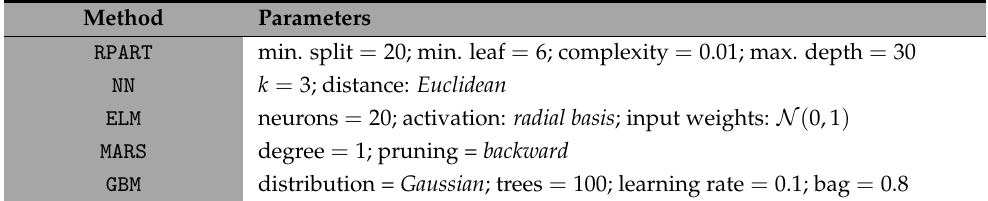
Table 2. Regression